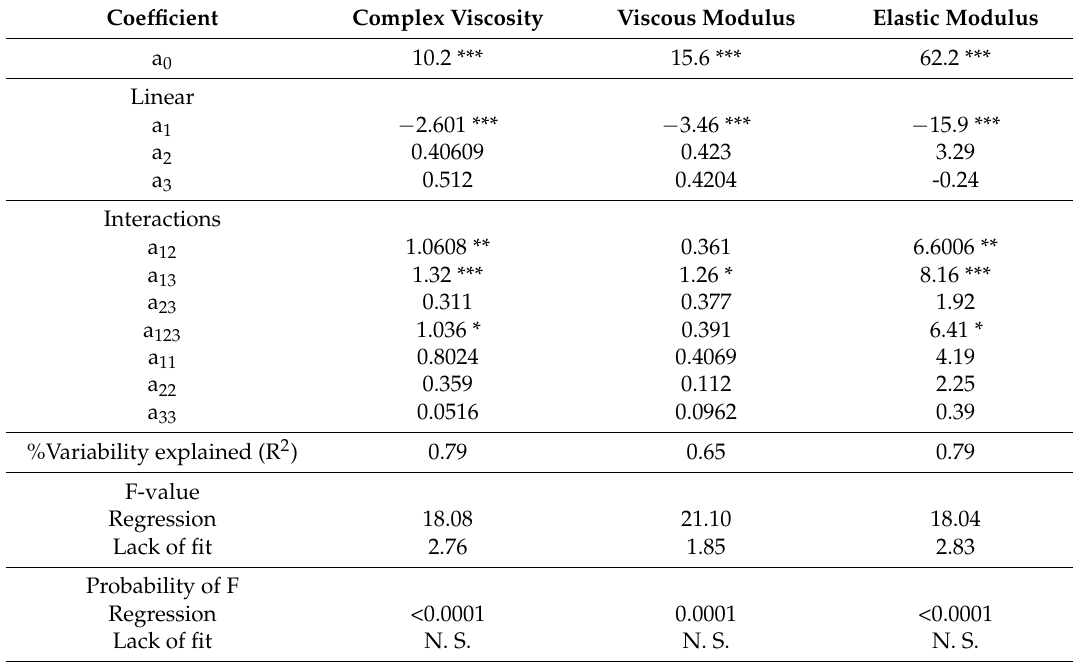
Table 2. Regression coefficient and analysis of variance for six response